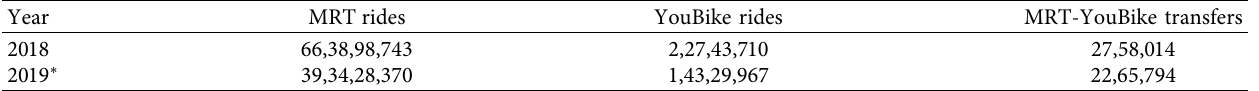
Table 2: Number of rides and transfers after preprocessing.